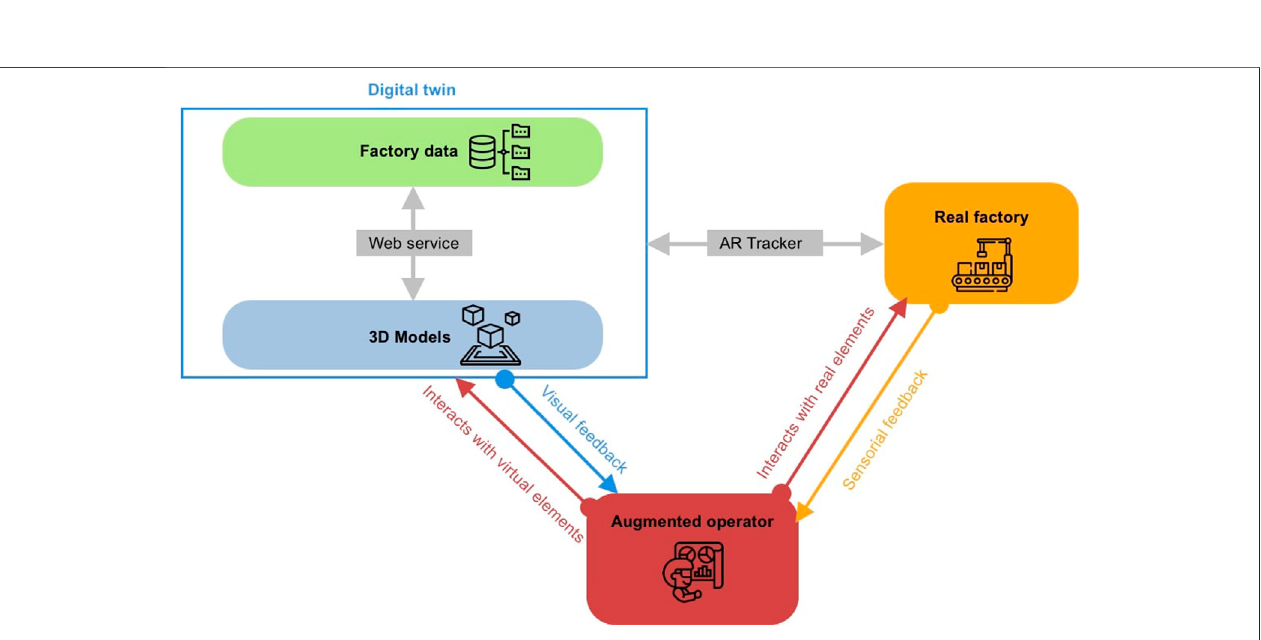
Frontiers in Virtual Reality |